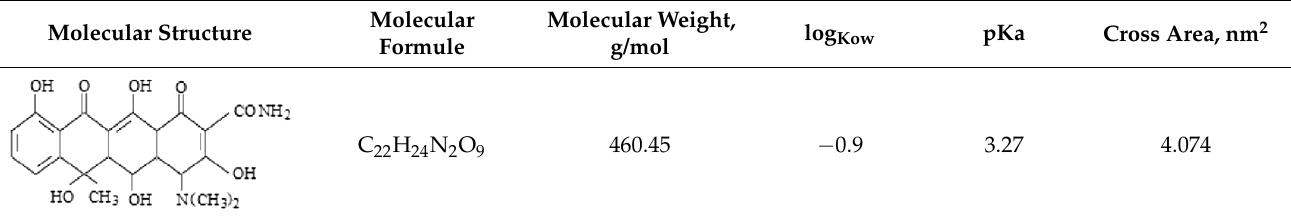
Table 2. Physical and chemical properties of oxytetracycline (OTC) [46,47]. Molecular Structure